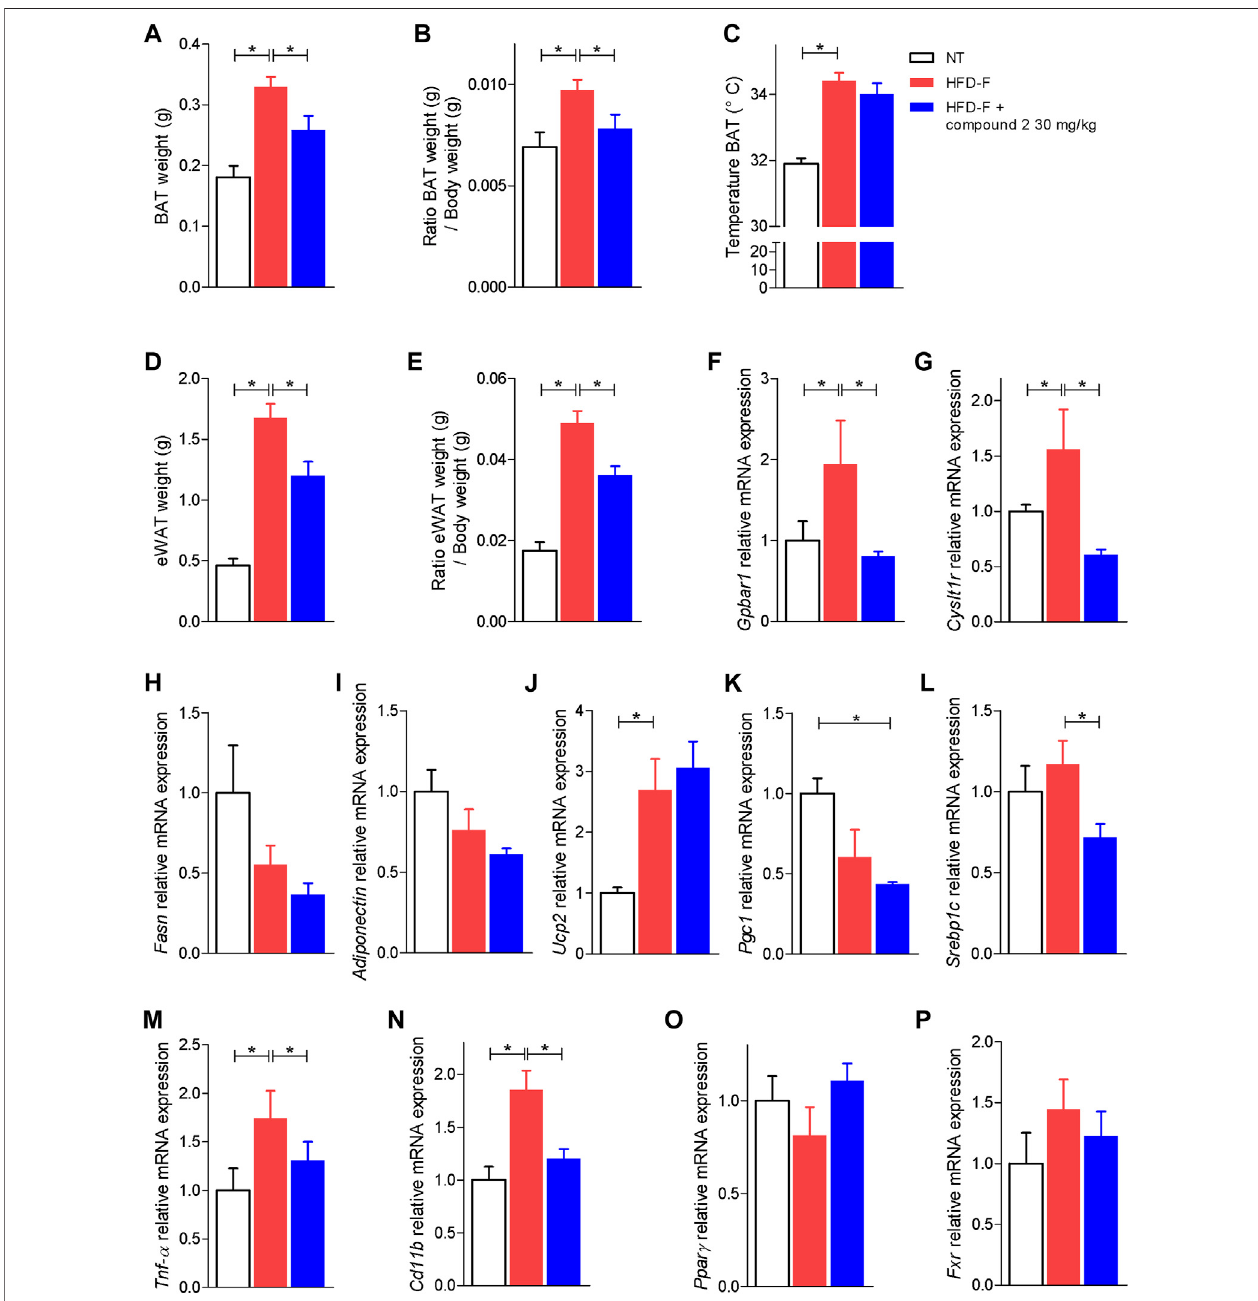
FIGURE9| Effectsofcompound2onadiposetissue.C57BL/6malemicewerefedahighfatdietandfructose(HFD-F)ornormalchowdietfor61 days.Fromday7 compound 2 was administered by oral gavage at the dose of 30 mg/kg/daily. (A) BAT weight, (B) ratio BAT weight (g)/body weight (g), and (C) temperature of BAT ( ° C) ontheday51. (D) eWATweightand (E) ratioeWATweight(g)/bodyweight (g).RelativemRNAexpression levelsof (F) GPBAR1, (G) CysLT 1 R, (H) Fasn, (I) Adiponectin, (J) Ucp2, (K) Pgc1, (L) Srebp1c, (M) Tnf- α , (N) Cd11b, (O) Ppar γ , and (P) Fxr in eWAT. Results are the mean ± SEM of 5-7 mice per group; * p < 0.05.